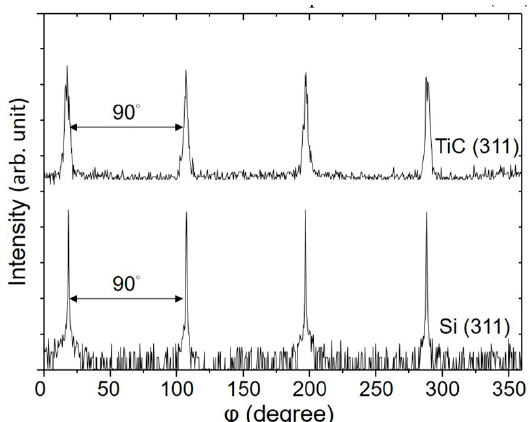
Figure 2. XRD φ -scan patterns of TiC 311 and Si 311 reflections for 5% CH 4 . Figure 2. XRD ϕ -scan patterns of TiC 311 and Si 311 reflections for 5% CH 4 . Figure 3. ( a ) X-ray rocking curves (XRC) of TiC 200 reflection for different CH 4 flow ratios and ( b ) variation of the XRC full width at half maximum (FWHM) with CH 4 flow ratio.